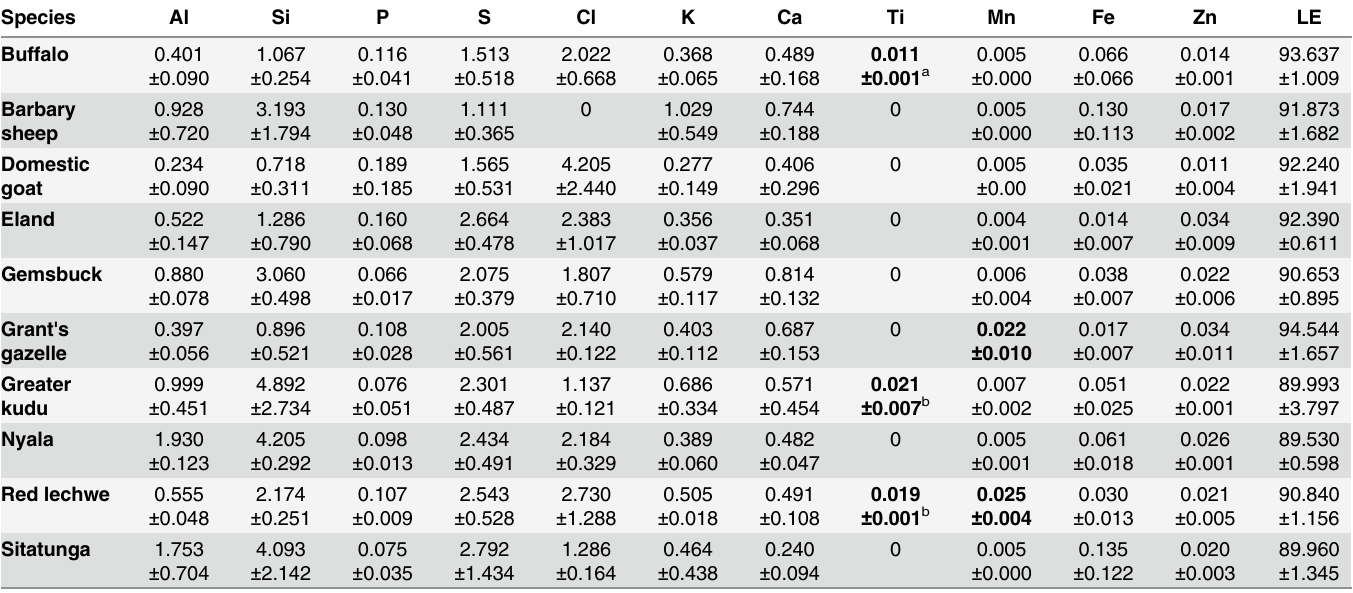
Table 2. Mean ( ± SD) elemental percentages in horn of 10 species of the Bovidae family.